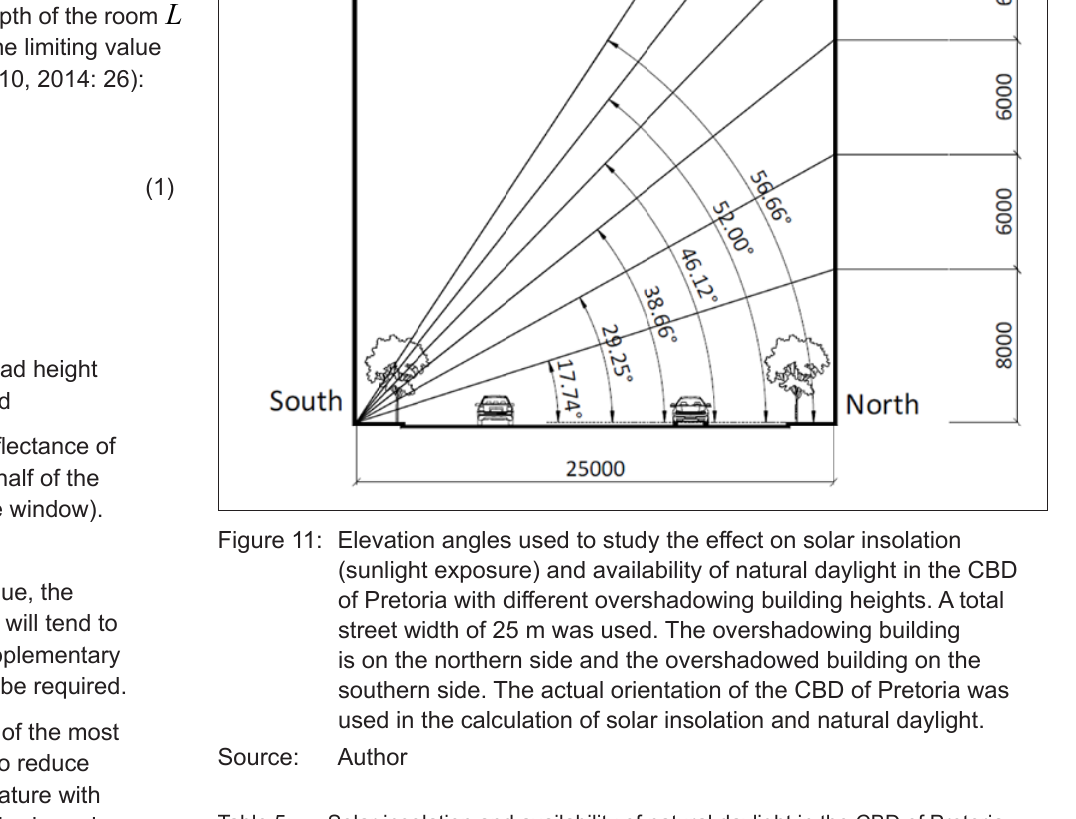
Solar insolation and availability of natural daylight in the CBD of Pretoria with different overshadowing building